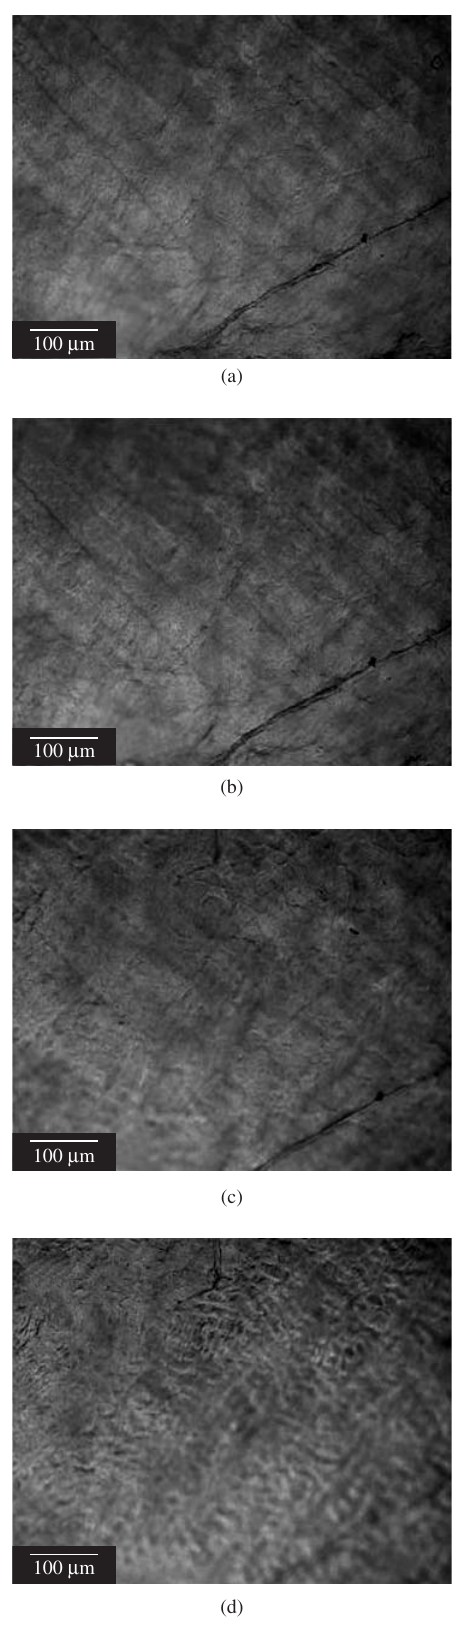
Figure 4. Freeze-drying microscope photographs of untreated bovine peri- cardium at different temperatures: a) 30.9 °C; b) 40.4 °C; c) 50.5 °C; and